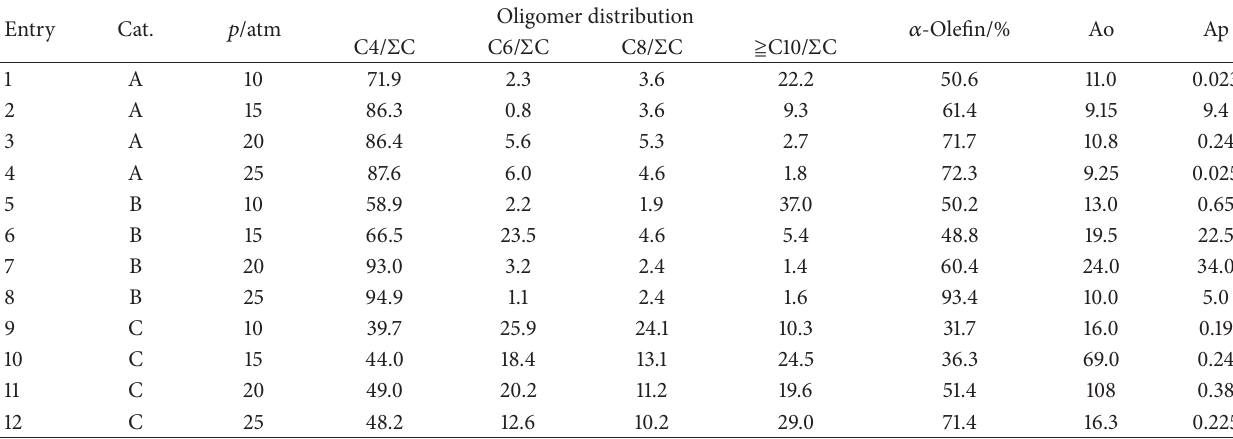
Table 3: Effects of pressure on the distribution of